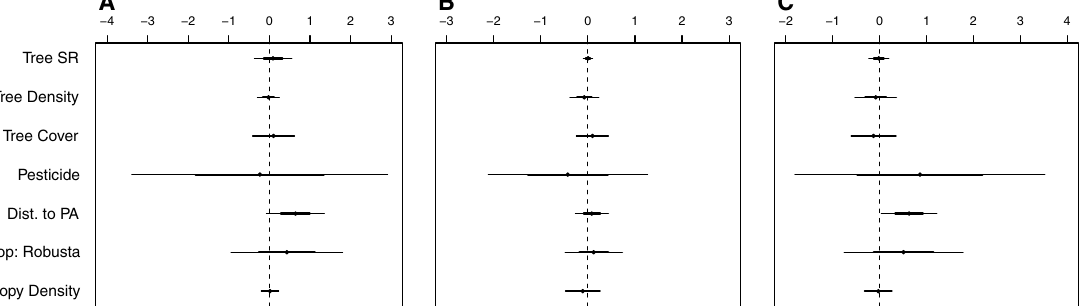
Figure 5. Model-averaged regression coefficients predicting ( A ) frugivore, ( B ) insectivore, and ( C ) omnivore density (individual birds per hectare) in arabica and robusta